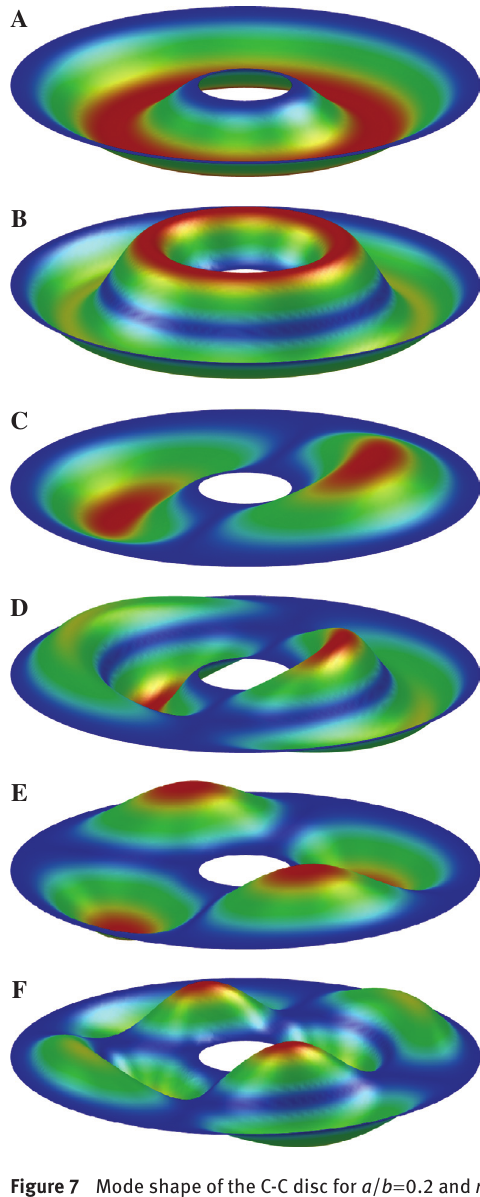
Figure 7 Mode shape of the C-C disc for a / b = 0.2 and n m = 0; n = 1, (B) m = 0; n = 2, (C) m = 1; n = 1, (D) m = 1; n = 2, (E) m = 2; n = 1, (F) m = 2; n =